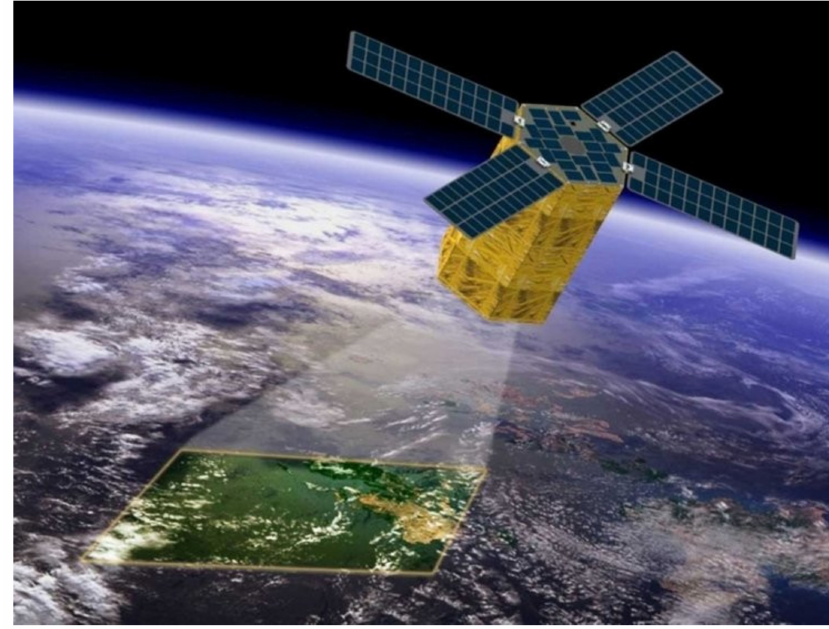
Figure 1. Remote sensing of the Earth.